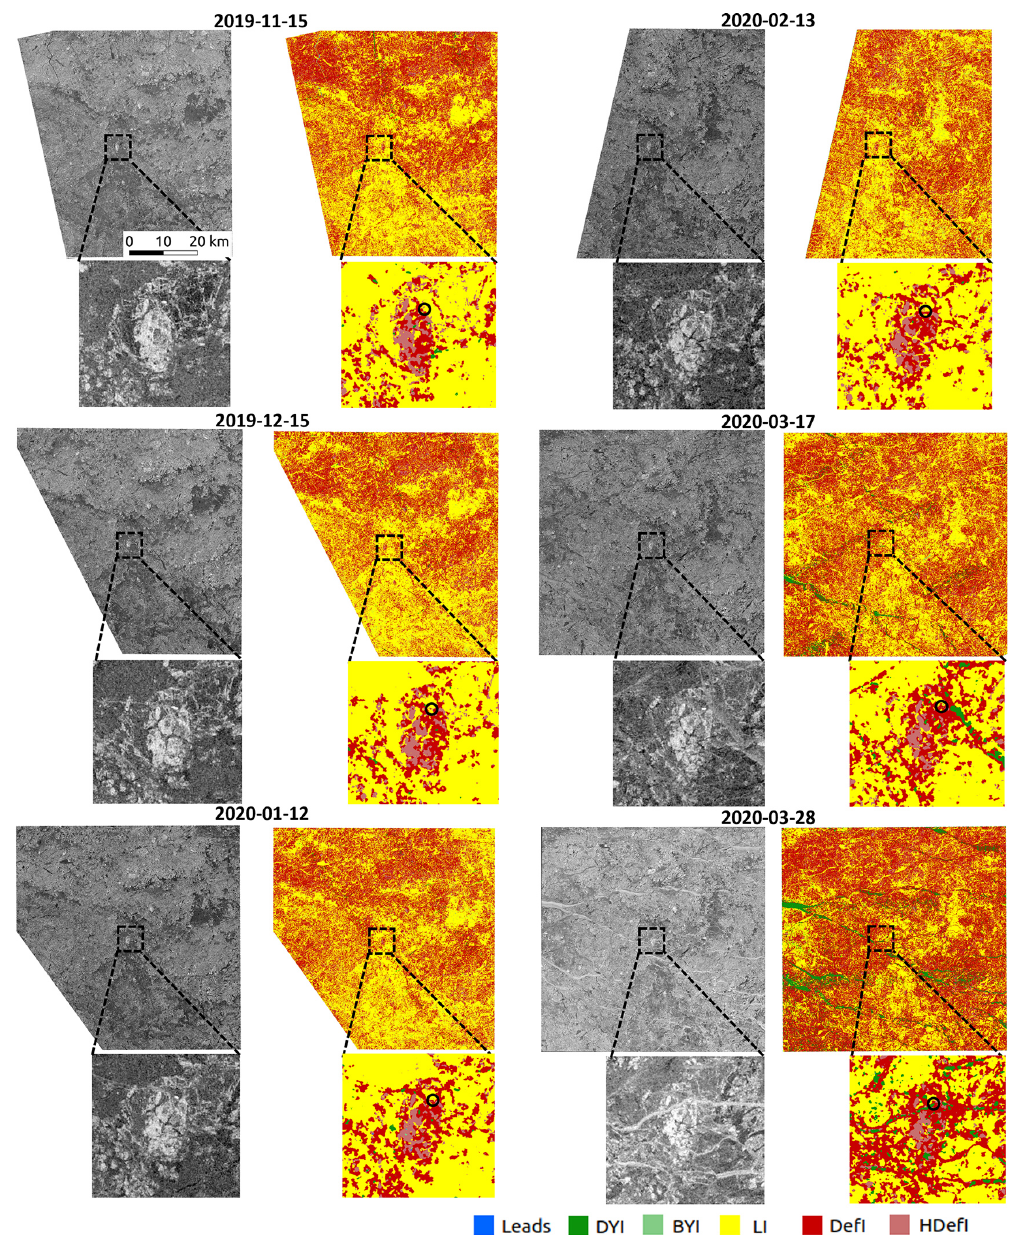
Figure 8. Classification maps of example TSX SC scenes; the zoomed-in patches focus on the MOSAiC ice floe, and black circles indicate the position of RV Polarstern